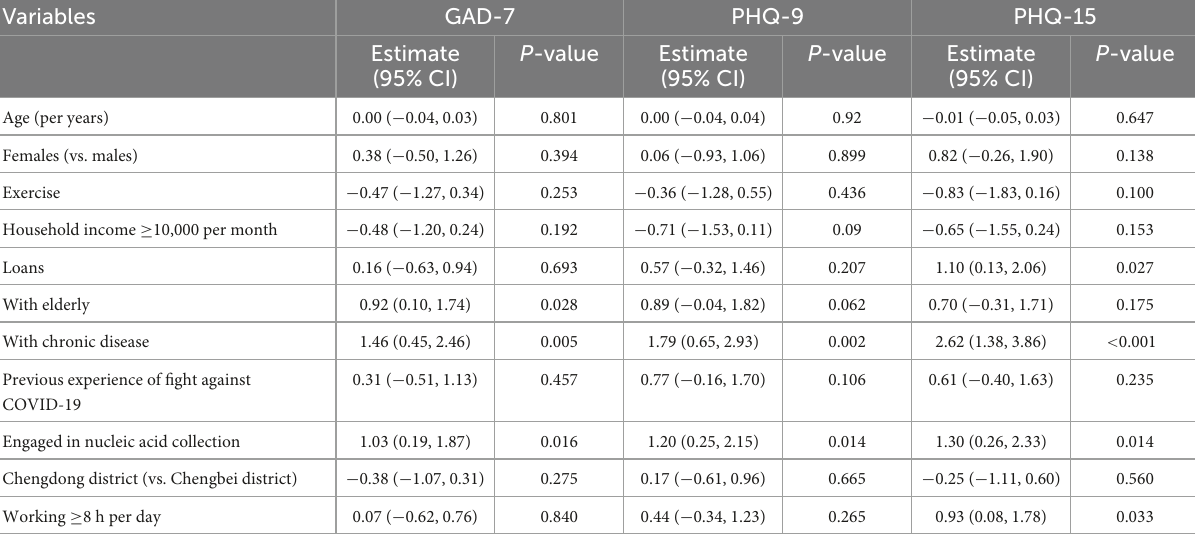
TABLE 2 Correlation between independent variables and scale scores estimated by generalized linear